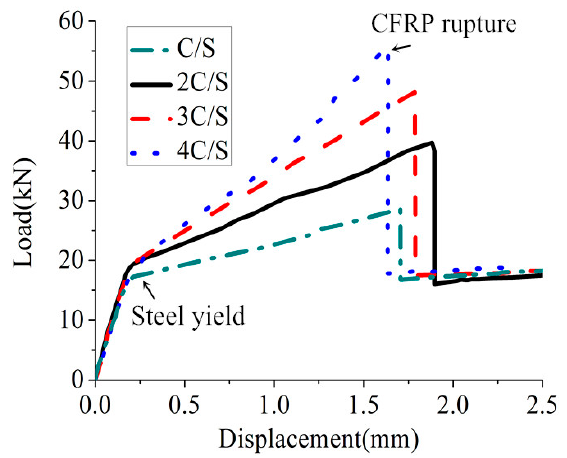
Figure 4. Load-displacement curves of series L specimens.